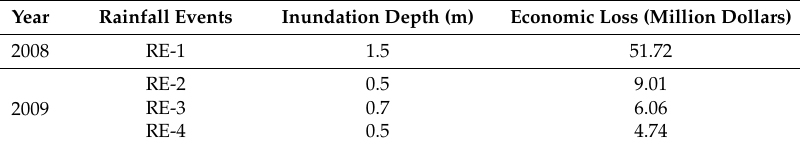
Table 10. Inundation depth and economic loss for different rainfall events [32].